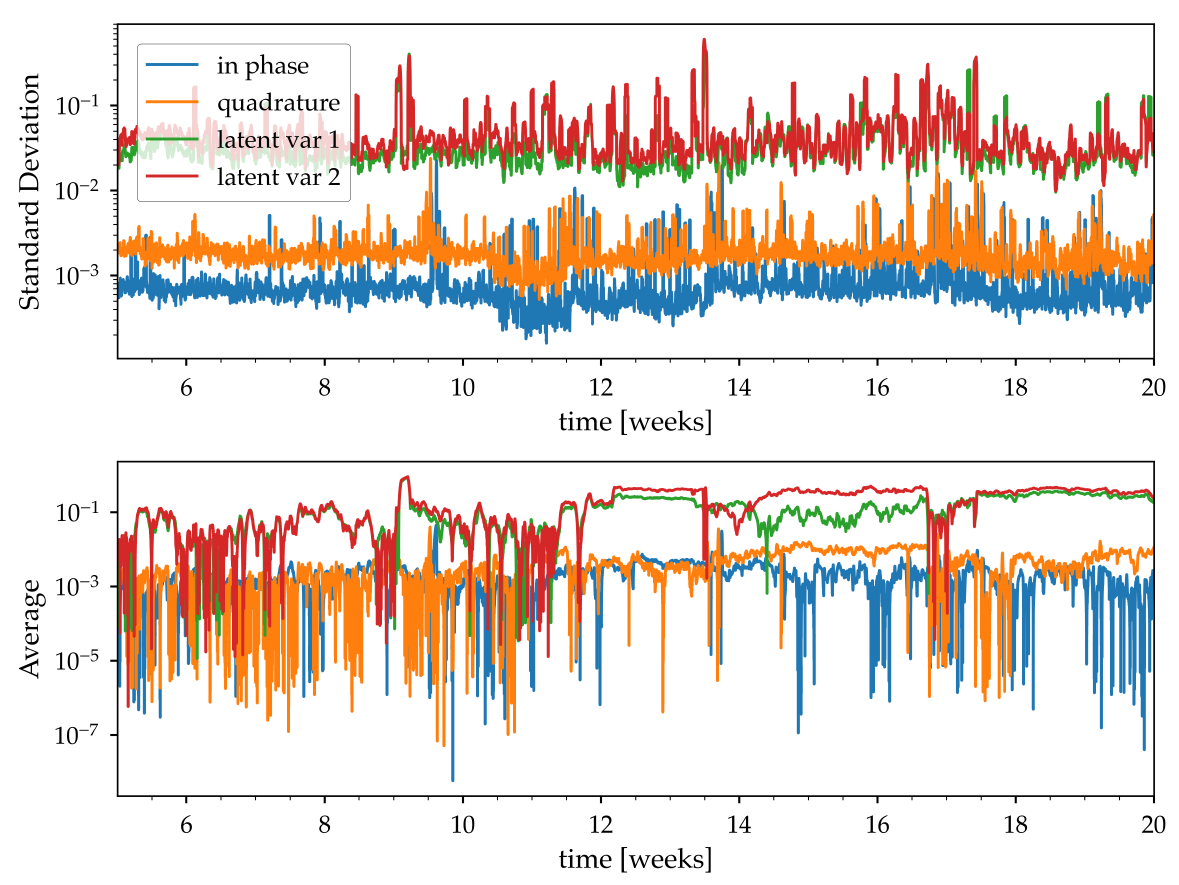
Figure 12. Top: rolling standard deviation of 100 points for the normalized latent space parameters and normalized vector sum components. Bottom: rolling average of 100 points for the normalized latent space parameters and normalized vector sum components. Top and bottom plots reference the same datasets. In-phase and quadrature components of the RF are the same as Figure 8, and latent space parameters correspond to those in the bottom of Figure